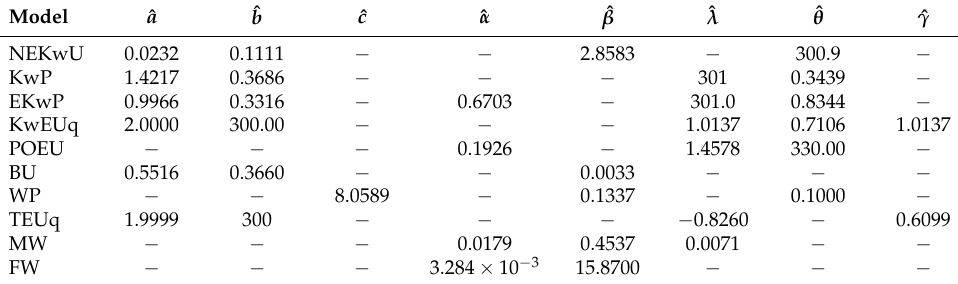
Table 6. MLEs of the parameters of the considered models for the first data